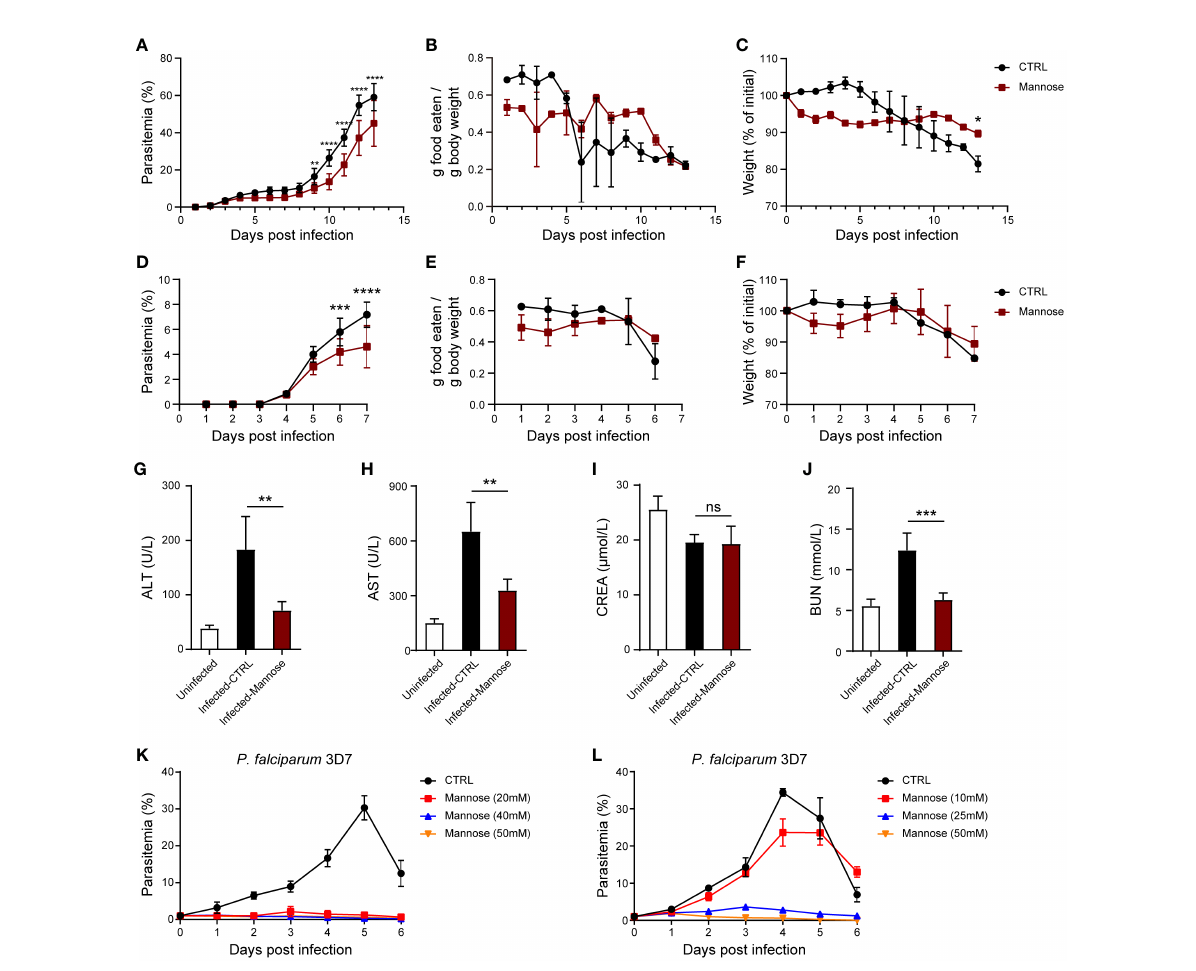
FIGURE 1 Mannose inhibits Plasmodium growth and is well tolerated in P. berghei -infected mice (A) Mannose (20%) inhibited P. berghei ANKA growth in BALB/c mice (n = 10 mice/group). Drinking water or mannose was supplemented by oral gavage every other day after infection. (B) Food intake by the infected mice in (A) . The average daily food consumption in the indicated group was expressed as grams of food eaten per total animal weight in that cage (5 mice/cage). (C) Daily body weight of the infected mice in (A) expressed as a percentage of the starting weight. (D) Mannose (20%) inhibited P. berghei ANKA growth in C57BL/6 mice (n = 8/group). Drinking water or mannose was supplemented by oral gavage every other day after infection. (E) Food intake by the infected mice in (D) (4 mice/cage). (F) Body weight of the infected mice in (D) . (G, H) Treatment with mannose signi fi cantly decreased serum ALT and AST levels in infected C57BL/6 mice 7 days post-infection (p.i.; n = 4/group). (I, J) Treatment with mannose alleviated kidney dysfunction in infected C57BL/6 mice 7 days p.i. (n = 4/group). (K, L) D-mannose inhibited blood-stage P. falciparum 3D7 growth in vitro . P. falciparum 3D7 was cultured in vitro with a starting parasitemia of 1% on day 0 (n = 3/group). The indicated dose of D-mannose was added to the media for 1 hour from day 0 and parasitemia determined daily before mannose treatment. CTRL vs. Mannose (20/40/50 mM): P < 0.0001; CTRL vs. Mannose (25/50 mM): P < 0.0001; CTRL vs. Mannose (10 mM): ns. All data are presented as mean ± SD and were analyzed by the Kruskal-Wallis ANOVA or two-way ANOVA with Tukey ’ s multiple comparisons test. * P < 0.05, ** P < 0.01, *** P < 0.001, **** P < 0.0001, and ns, not signi fi